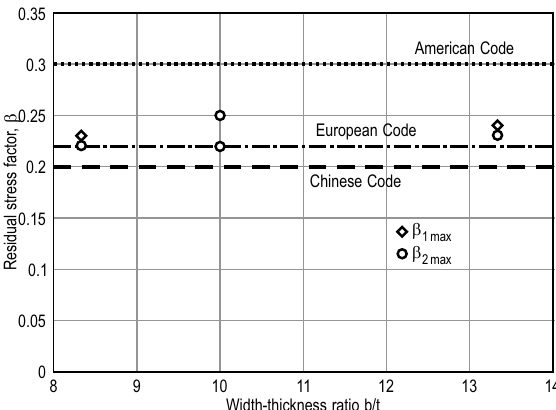
Fig. 8. Residual stress distribution modelof hot rolled steel equal angle in American, European, and Chinese Codes